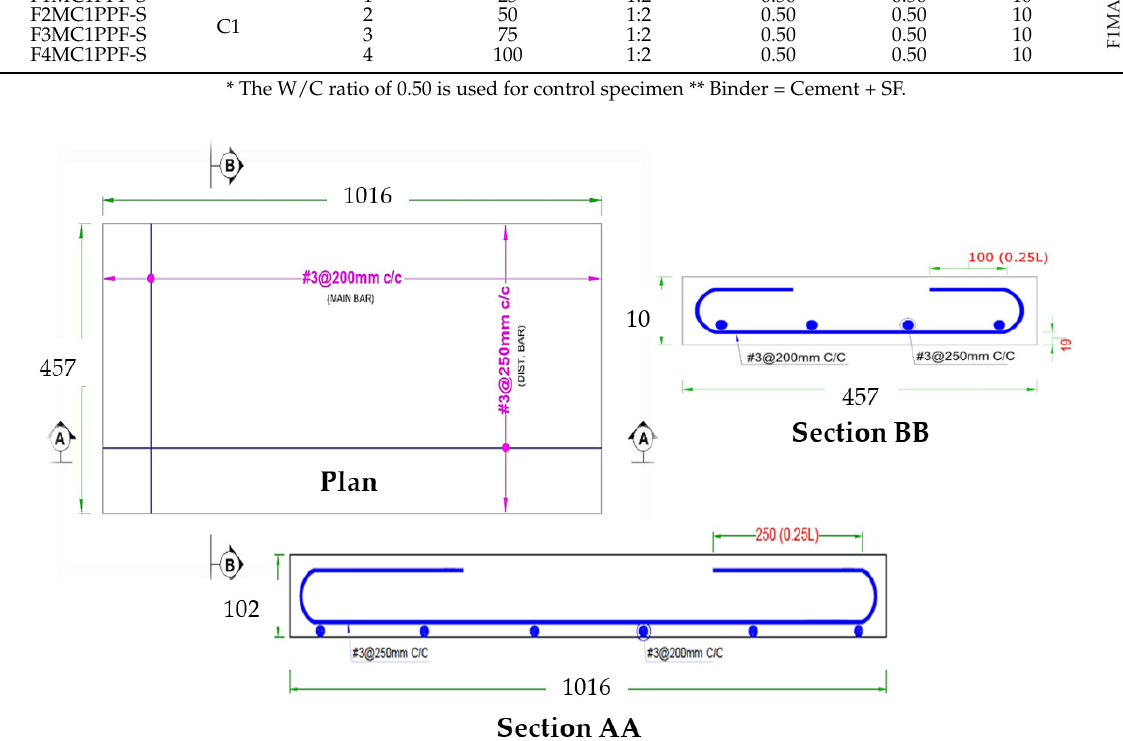
Figure 6. ( a ) Placing of ferrocement mesh and mortar; ( b ) Spreading of mortar over the mesh with a trowel; ( c ) Final finish with a trowel; ( d ) Whitewash on sides of slabs.